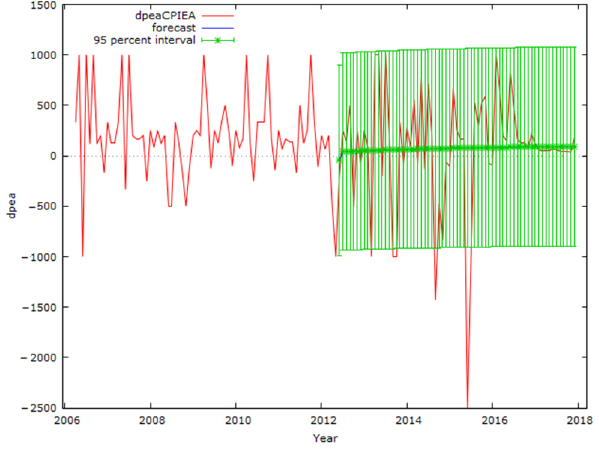
Figure A4. Time series forecasting for dpea, the in-sample January 2000–May 2012, and the out-of-